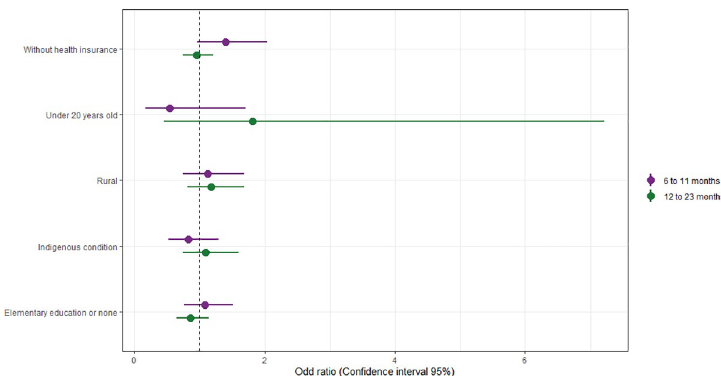
Fig 4. Factors associated to incomplete basic vaccination schemes by two age